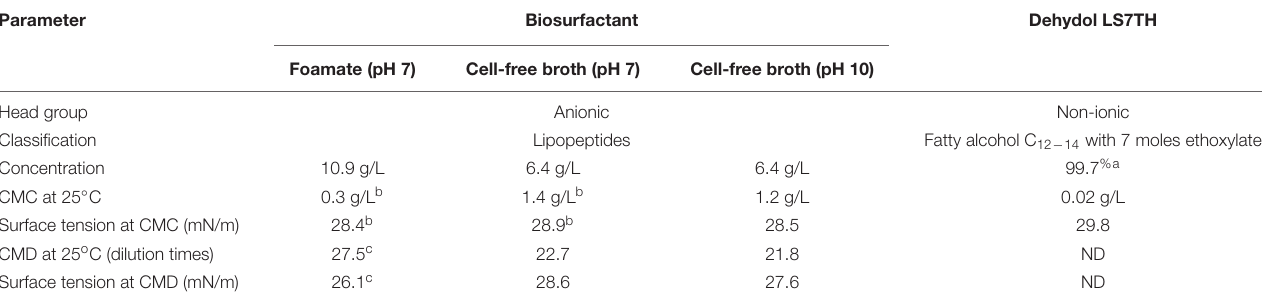
TABLE 1 | Properties of surfactants.